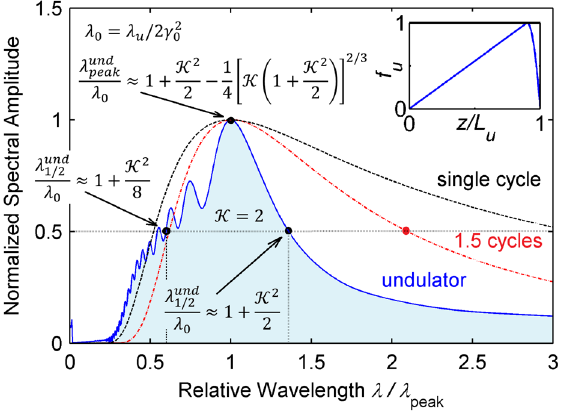
FIG. 4. Comparison of the spectra of the single-cycle and 1.5-cycle pulses to the on-axis undulator spectrum. The undulator profile is depicted in the inset. The undulator spectrum is calculated numerically using (11) but neglecting diffraction. The wavelength for each spectrum is normalized in the way that the peaks of the spectra are aligned. The wavelengths corresponding to the peak value of the undulator spectrum λ und and half of it λ und 1 are presented as peak = 2